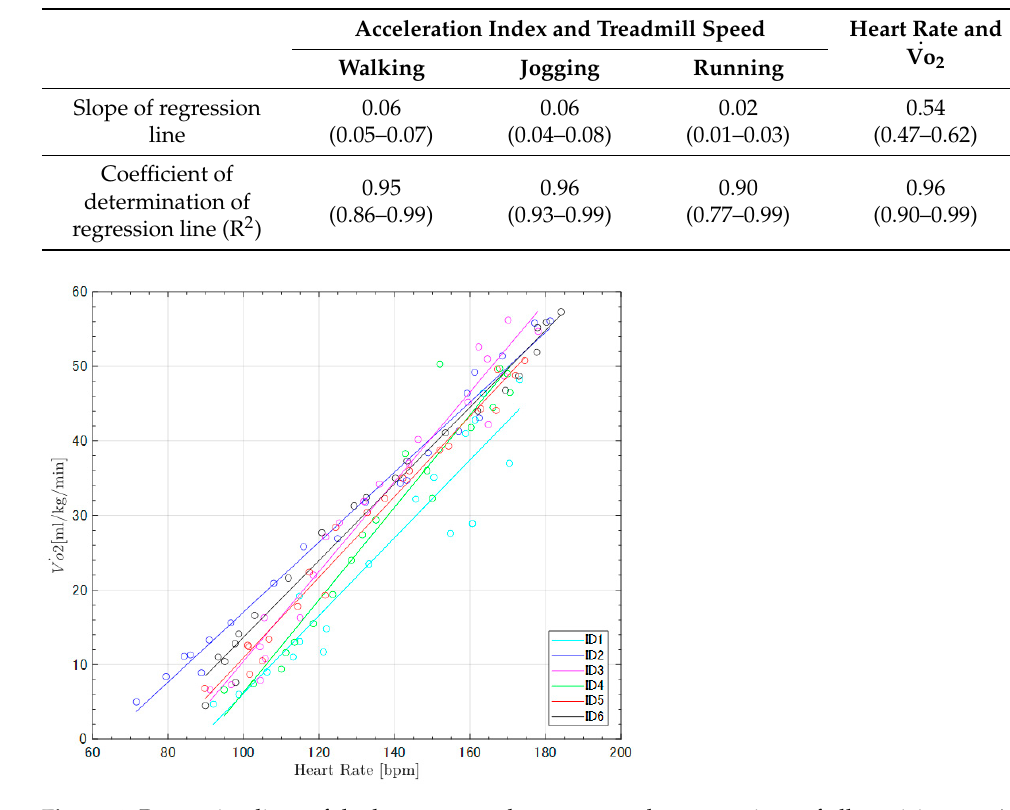
Figure 4. Regression lines of the heart rate and oxygen uptake comparison of all participants. All participants showed a linear relationship with small variations (r ≥ 0.96).